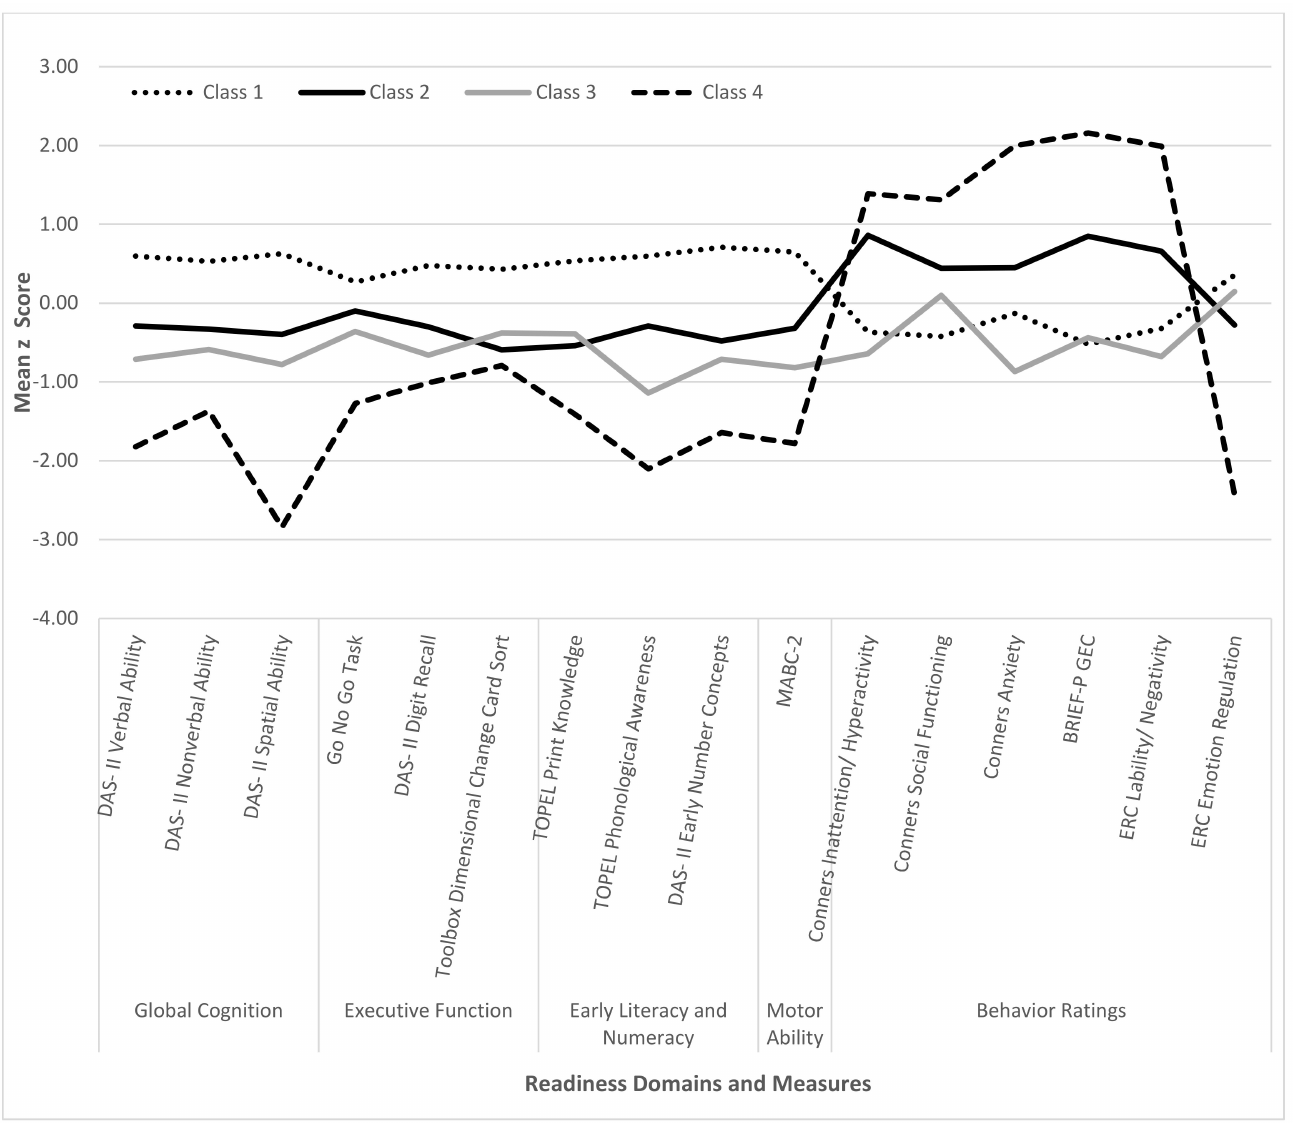
Figure 1. Latent class differences in mean z scores for readiness measures. The 37 children assigned to latent class 1 had the best readiness outcomes, with scores on performance tests and behavior ratings falling well within the average range. Only